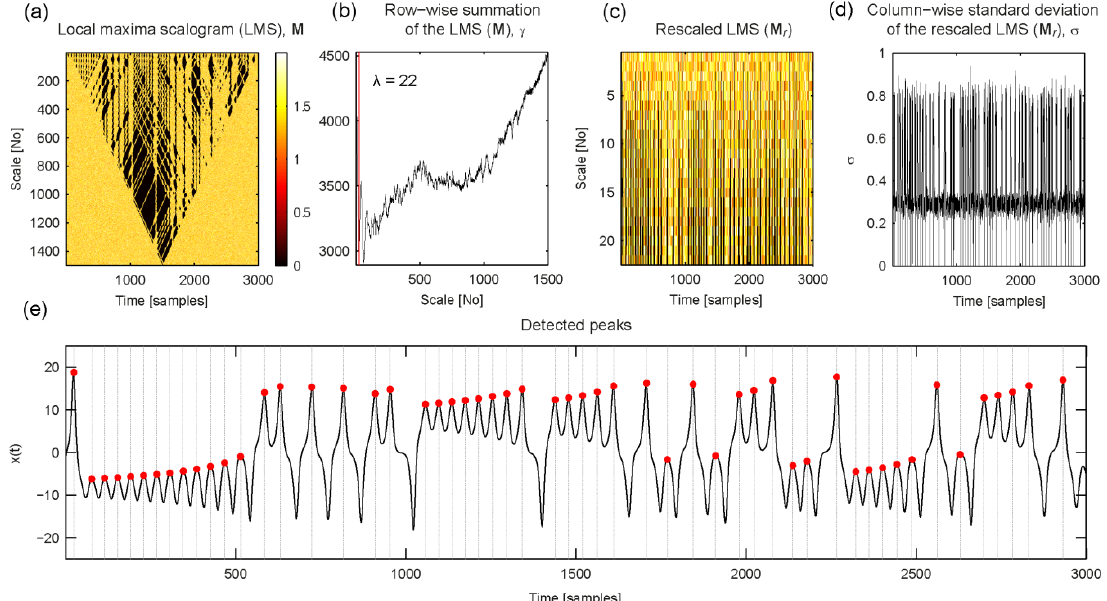
Figure 10. Results of applying the AMPD algorithm to the x ( t ) time series of the Lorenz